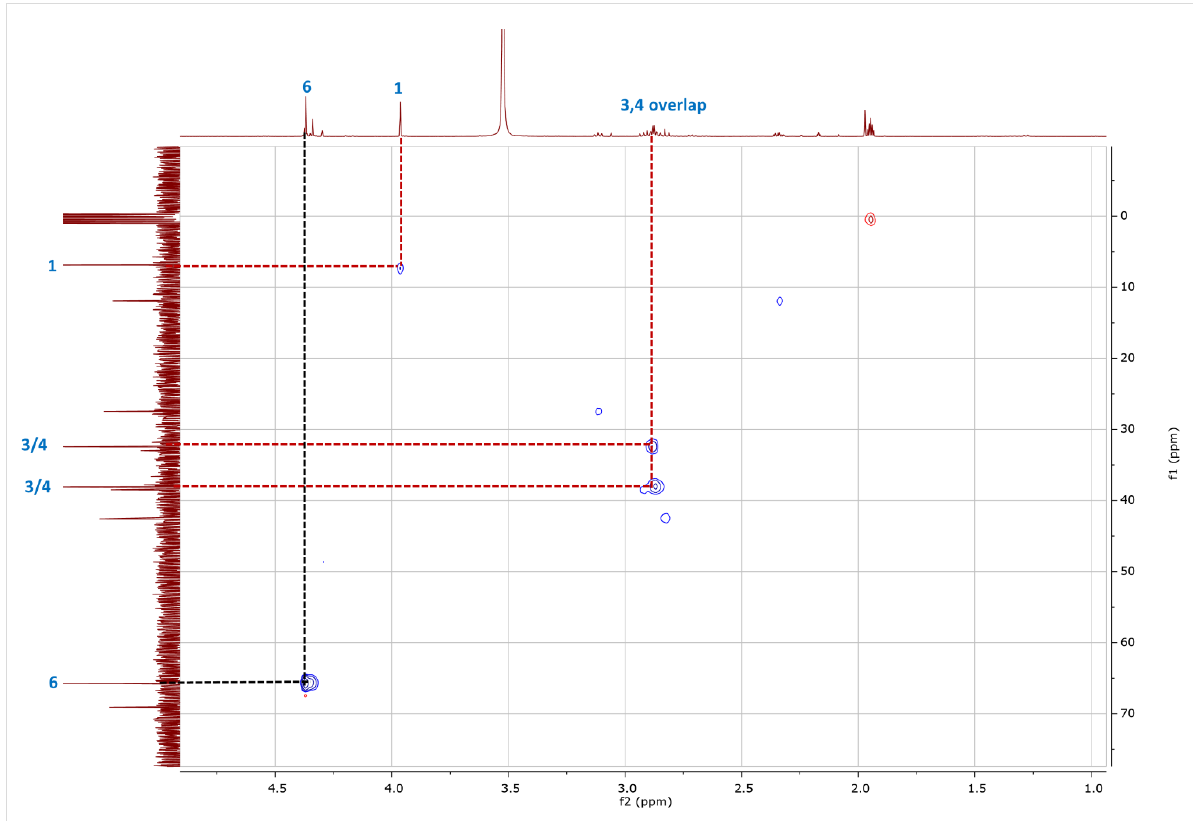
Figure 2: 1 H— 13 C HSQC spectrum for α -iodo intermediate 9 in CD 3 CN in the range of 0.90–5.00 ppm (for 1 H NMR signals) and − 1.0–77.0 ppm (for 13 C NMR signals), respectively.